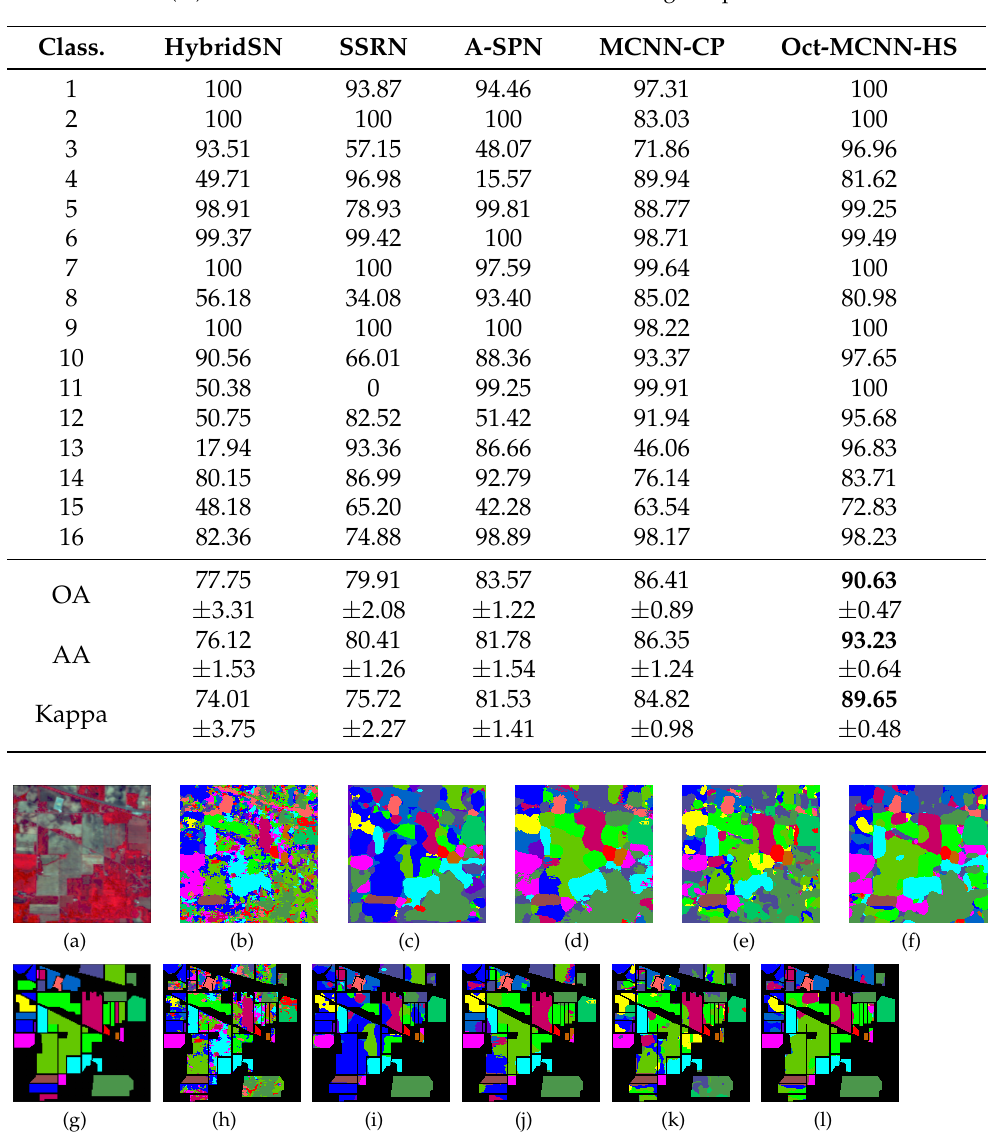
Table 9. Results (%) for the Salinas Scene dataset with 0.1% training samples.